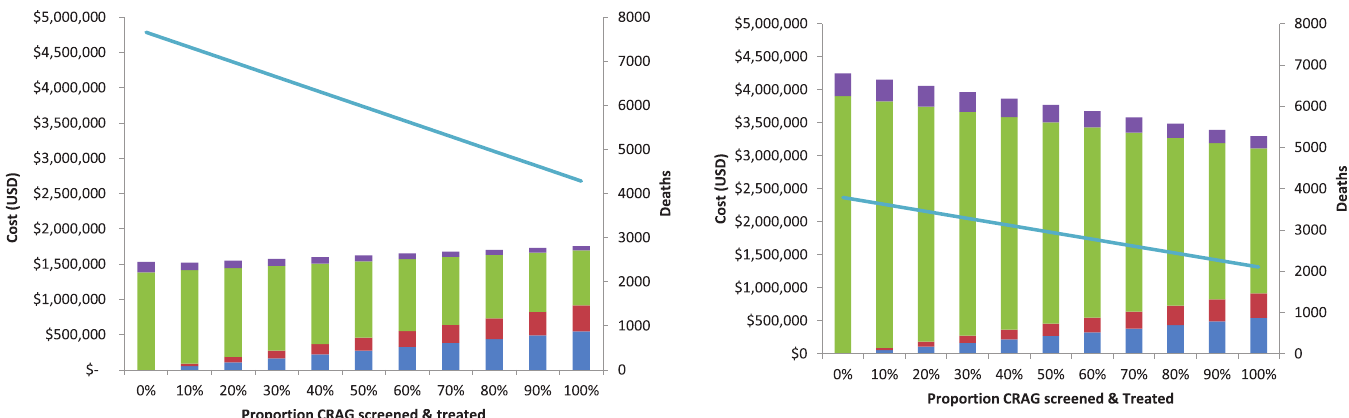
Fig 7. Cost savings of CrAg screening with different treatment regimens for those with cryptococcal meningitis. Left: CrAg screening and preemptive treatment where cryptococcal meningitis is treated with fluconazole alone. Right: Cryptococcal meningitis is treated with amphotericin + flucytosine. For analyses where meningitis was treated with fluconazole alone (which is highly ineffective), CrAg screening is cost-effective, but not cost-saving, because the treatment for meningitis is inexpensive. However, full implementation of CrAg screening resulted in a 44% reduction in mortality, given the poor efficacy of fluconazole in the treatment of meningitis. Conversely, if meningitis is treated with amphotericin + flucytosine, CrAg screening is cost-saving because treatment for meningitis is expensive, and reduces mortality. Mortality reductions are less dramatic with meningitis regimens that are more effective. In all scenarios, CrAg screening reduced mortality and was cost-effective.